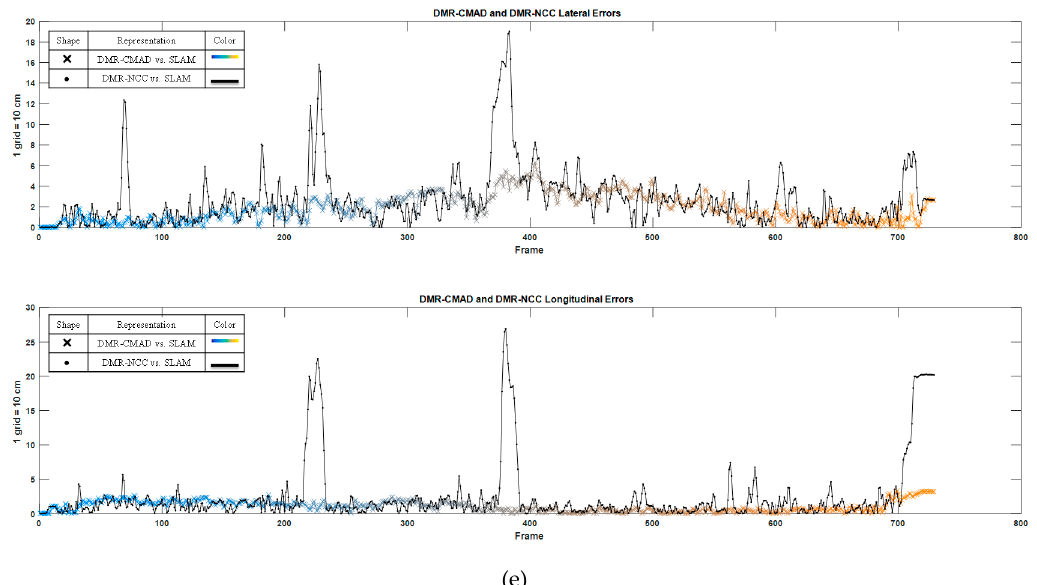
Figure 18. Comparison of the DMR–CMAD and DMR–NCC trajectories and the SLAM trajectory. ( a ) DMR–CMAD trajectory. ( b ) Local magnification (start and end section). ( c ) Local magnification (middle section). ( d ) Local magnification (U-turn around the landmark). ( e ) Lateral and longitudinal errors between the DMR–CMAD and DMR–NCC trajectories and the SLAM trajectory.